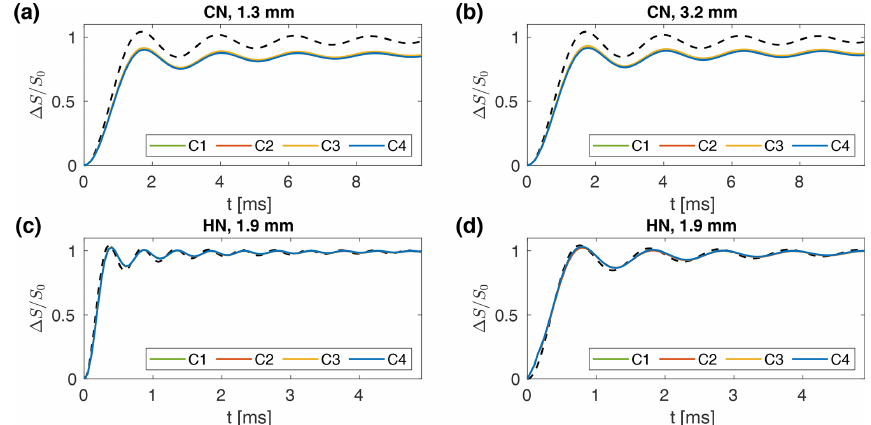
Figure 8. (a, b) Simulated REDOR curves for a CN spin pair, with a value of 2kHz for the anisotropy of the dipolar coupling tensor δ IS 2 π at a carbon resonance frequency of 150MHz in a 1.3mm MAS probe (a) and a 3.2mm MAS probe (b) , assuming a spinning frequency of 20kHz. The nominal rf field strengths were set to 100kHz (62.5kHz) for C and 62.5kHz (50kHz) for N in the 1.3mm (3.2mm) probe. For all four cases (C1–C4), the resulting recoupling efficiencies are significantly lower than the theoretical REDOR curve (dashed line). Amplitude modulations (C2 and C4) lead to a further marginal deterioration of the recoupling efficiency. The remaining two cases (C1 and C3) are indistinguishable. (c, d) Simulated REDOR curves for a HN spin pair with a δ IS of 24kHz at a proton resonance frequency of 2 π 600MHz in a 1.9mm MAS probe, assuming a spinning frequency of 40kHz. The nominal rf field strengths were set to 125kHz for H and 50kHz for N. A scaling of the effective dipolar coupling is achieved by shifting one pulse ( c ; delay until first pulse t 1 = 2 . 5µs) or both pulses ( d ; delay until first pulse t 1 = 16µs) per rotor period. No significant deviation in any of the four cases (C1–C4) from the theoretical REDOR curves (dashed lines) is observed, indicating the robustness of these REDOR implementations towards rf